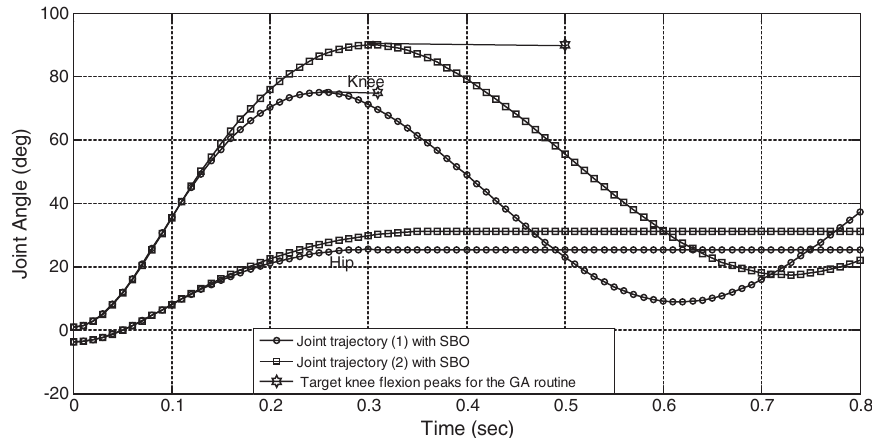
Fig. 7. Knee and hip joint trajectories (1) and (2) with spring parameters optimized for higher target knee flexion peaks (0.31sec, 75 ◦ ) and (0.5sec, 90 ◦ respectively. The arrowed lines indicate the distances of the actual knee flexion peaks from the target points as used in the GA